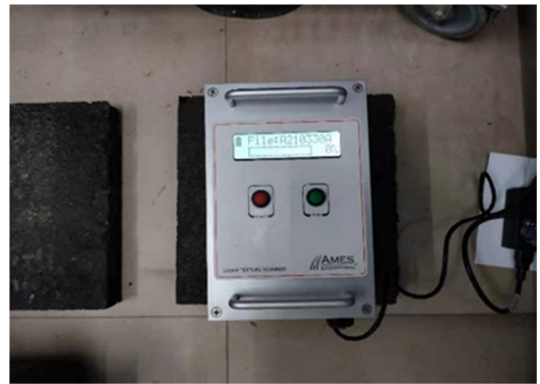
Figure 8. Ames texture scanner.